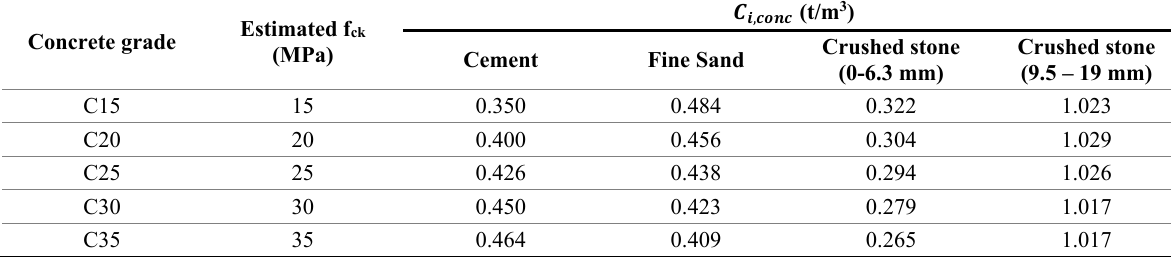
Table 3. Materials consumption for one cubic meter of concrete